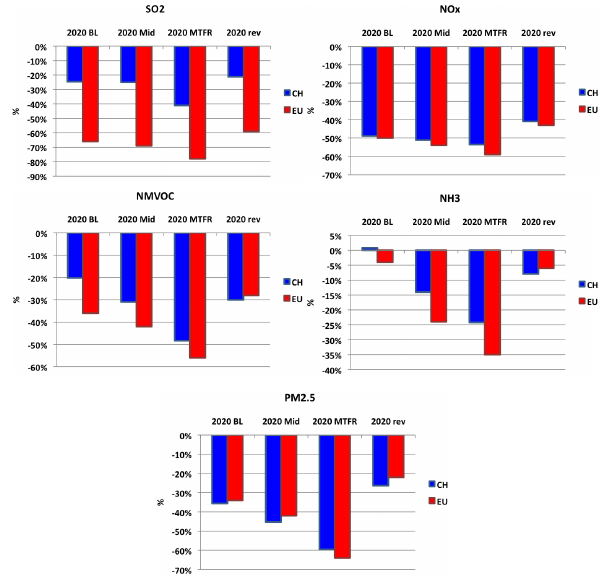
Figure 1. Relative changes (%) in annual emissions of SO 2 , NO x , NMVOC, NH 3 and PM 2 . 5 with respect to reference year (2005) for various scenarios in Switzerland (CH) and the European countries (EU) (for definition of scenarios see